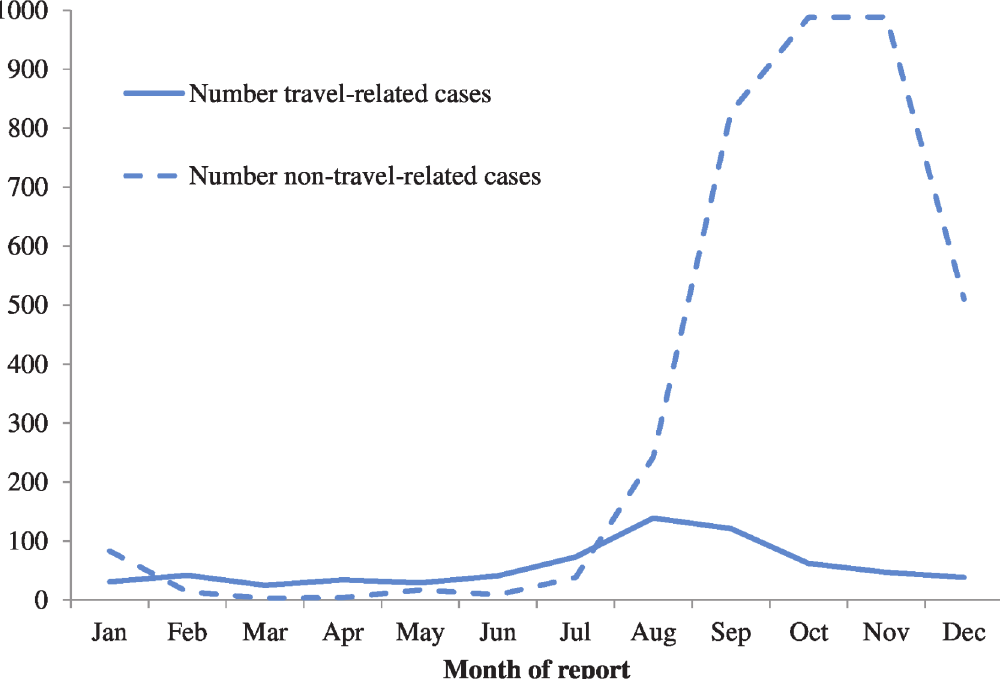
Fig 4. Number of confirmed cases of dengue fever reported to the National Disease Surveillance System by month of report and travel history, Taiwan, 2010 – 2012.